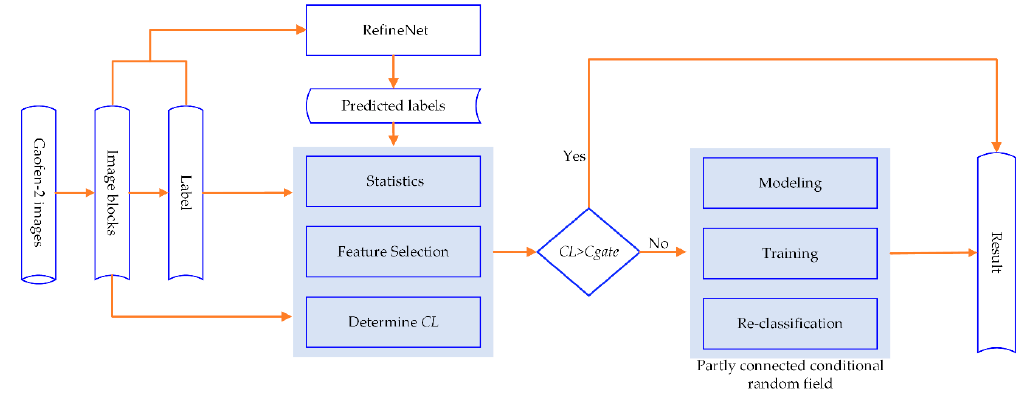
Figure 3. Flowchart of the proposed approach. CL: Confidence level.